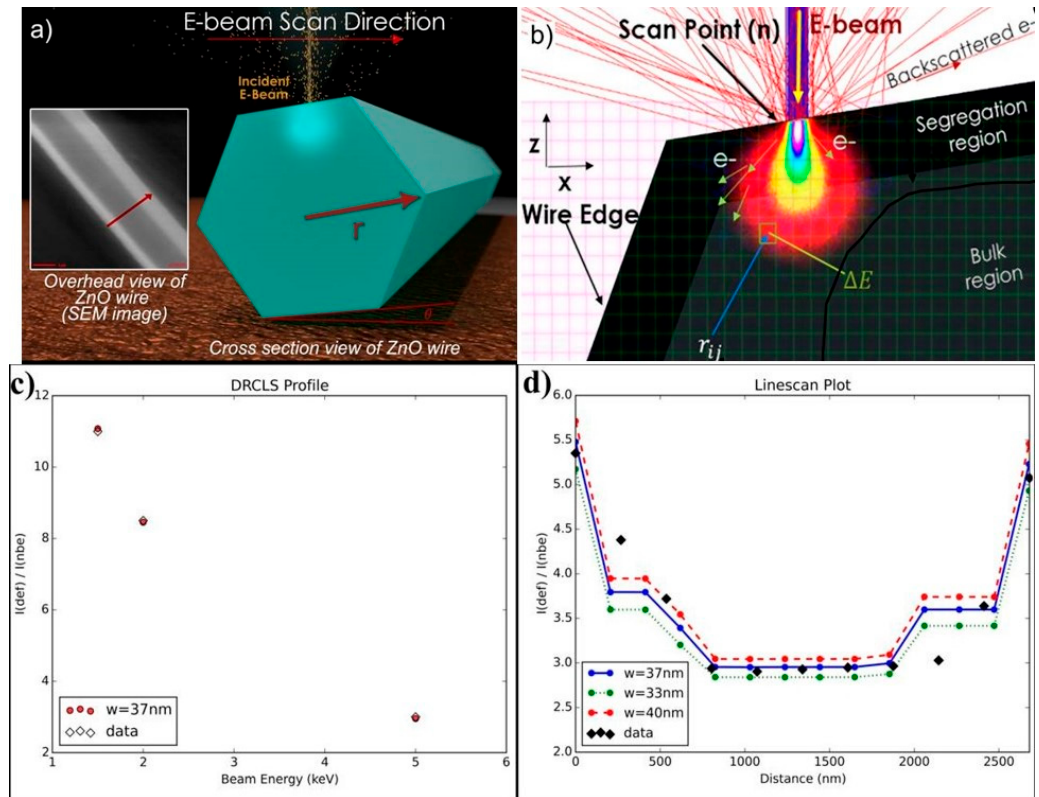
Figure 6. ( a ) Illustration of the line-scan CLS measurement process and SEI picture of a typical electron beam track across the ZnO wire diameter. ( b ) Illustration of electron-hole pair creation geometry and geometric parameters used for the defect profile simulation. ( c ) Single spot depth dependence measurement of I(defect)/I(NBE) intensity ratio versus incident beam energy E B . ( d ) 5 keV line-scan data (black dots) and best fit (blue line and dots) showing defect emissions extending nearly 1000 nm into the microwire bulk. Reprinted with permission from the Royal Society of Chemistry [15].